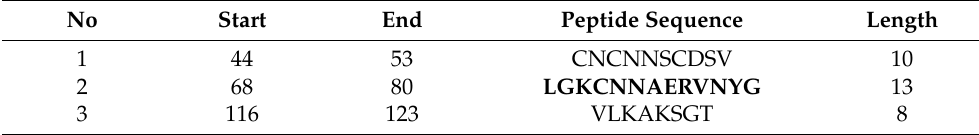
Table 2. Synthesized peptides of CD8 β molecules in olive